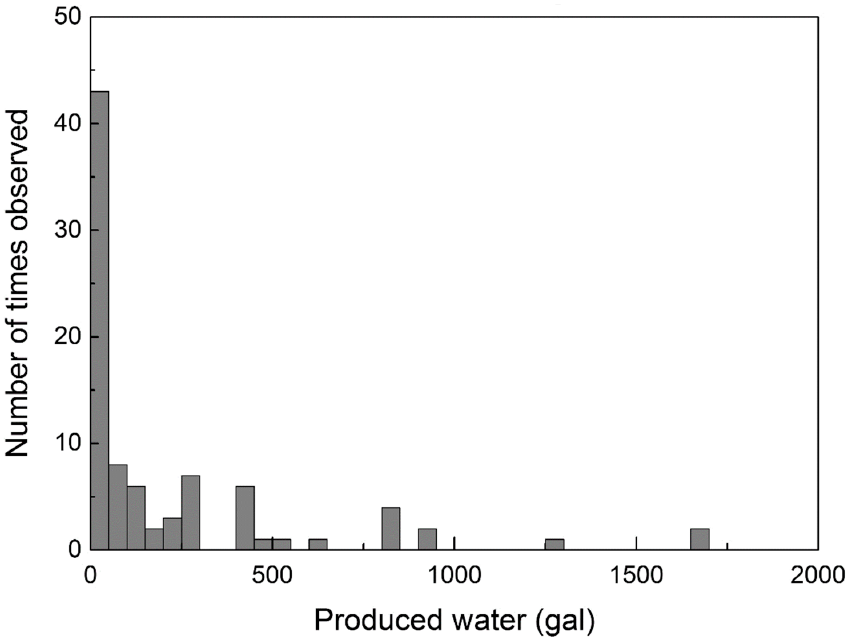
Figure 3. Histogram of the net (total volume—recovered volume) produced water spill volume for spills occurring in counties overlying the South Platte Alluvial Aquifer. These data exclude three spills with volumes above 2800 gallons (~67 bbl, ~10,599 L) for visualization purposes. Note. 1 bbl = 42 gallons = ~159 L.